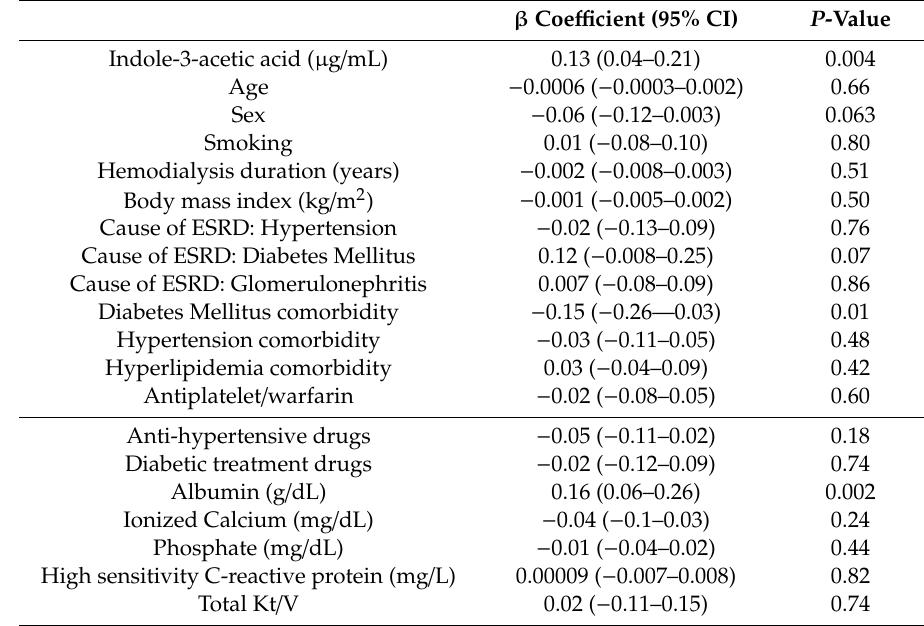
Table 2. Associations of circulating Indole-3-acetic acid level and other clinical parameters with stem cell factor in the multivariate linear regression